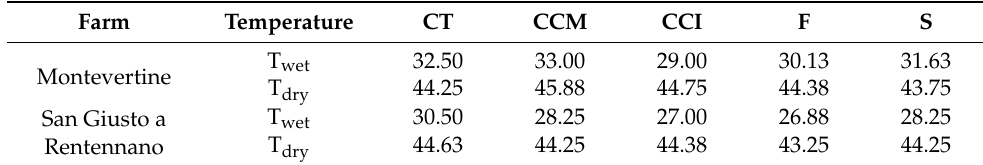
Table 3. T wet and T dry temperatures ( ◦ C) of the two farms divided by treatment. Farm Temperature CT